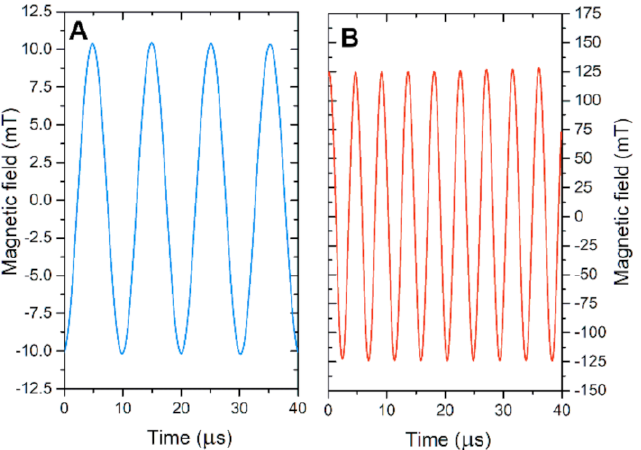
Figure 1. Measured alternating magnetic field waveforms. ( A ) 100 kHz low magnetic field generator and ( B ) 200 kHz high magnetic field